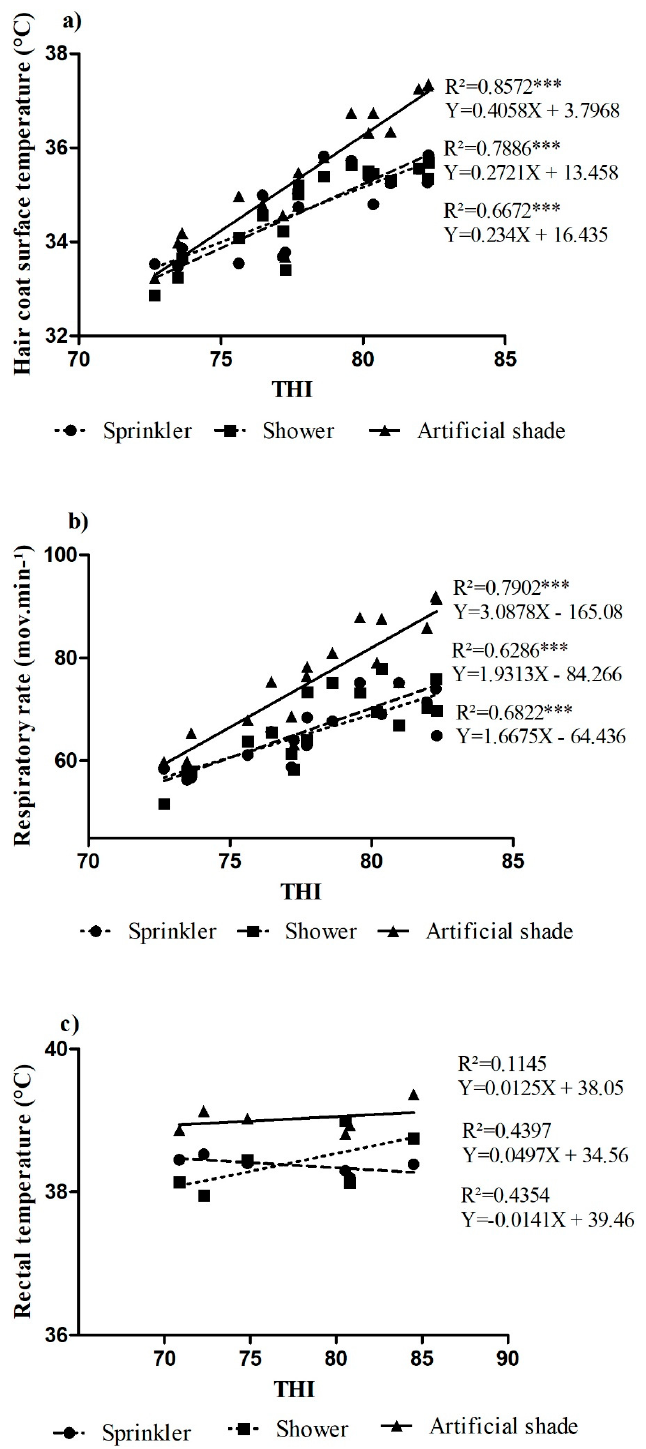
Figure 4. ( a ) Regression analysis of hair coat surface temperature ( ◦ C) of animals subjected to THI sprinkler + artificial shade, shower + artificial shade, and artificial shade systems; ( b ) Regression analysis of respiratory rate (mov. Min − 1 ) of animals subjected to THI sprinkler + artificial shade, shower + artificial shade, and artificial shade systems. ( c ) Regression analysis of rectal temperature ( ◦ C) of animals subjected to THI sprinkler + artificial shade, shower + artificial shade, and artificial shade systems. Note: *** significant correlation coefficient ( p <